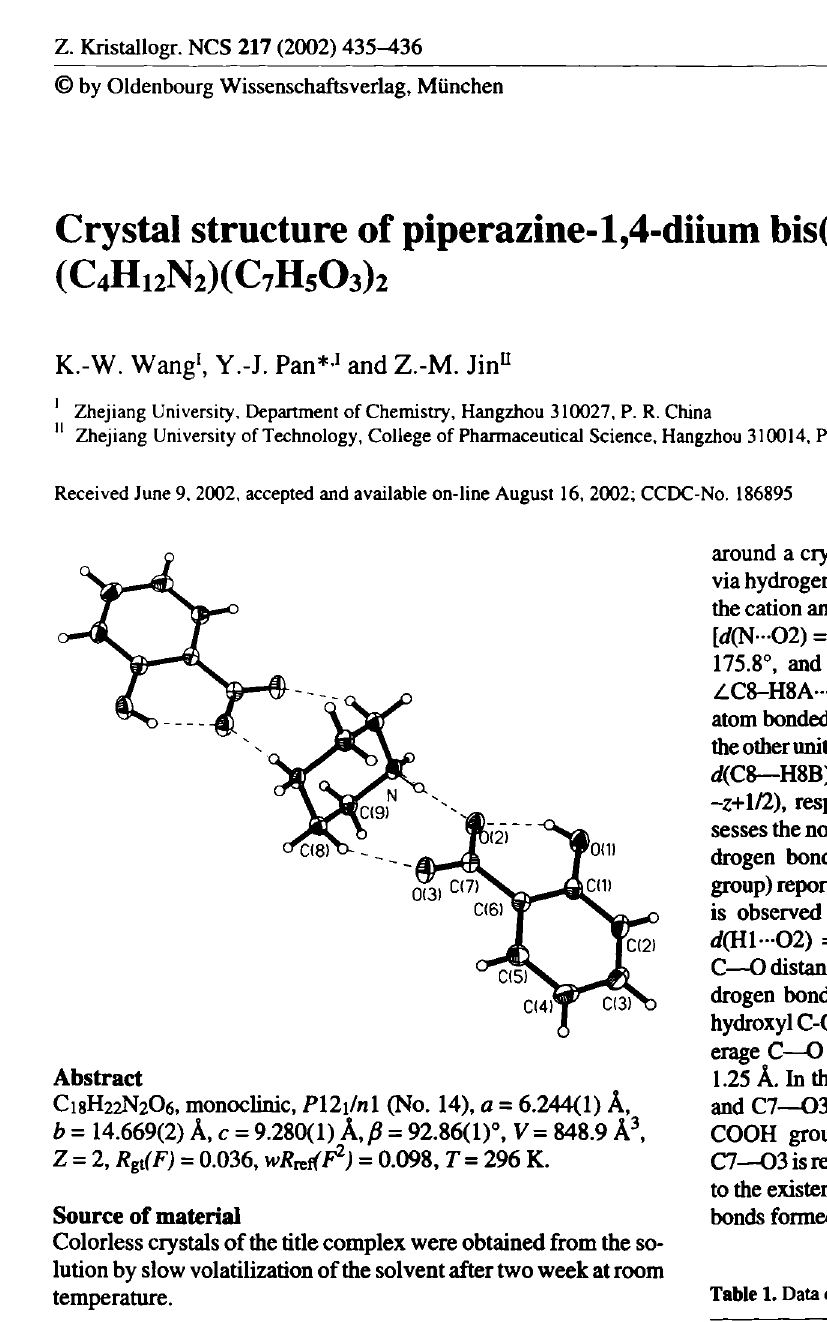
Table 1. Data collection and